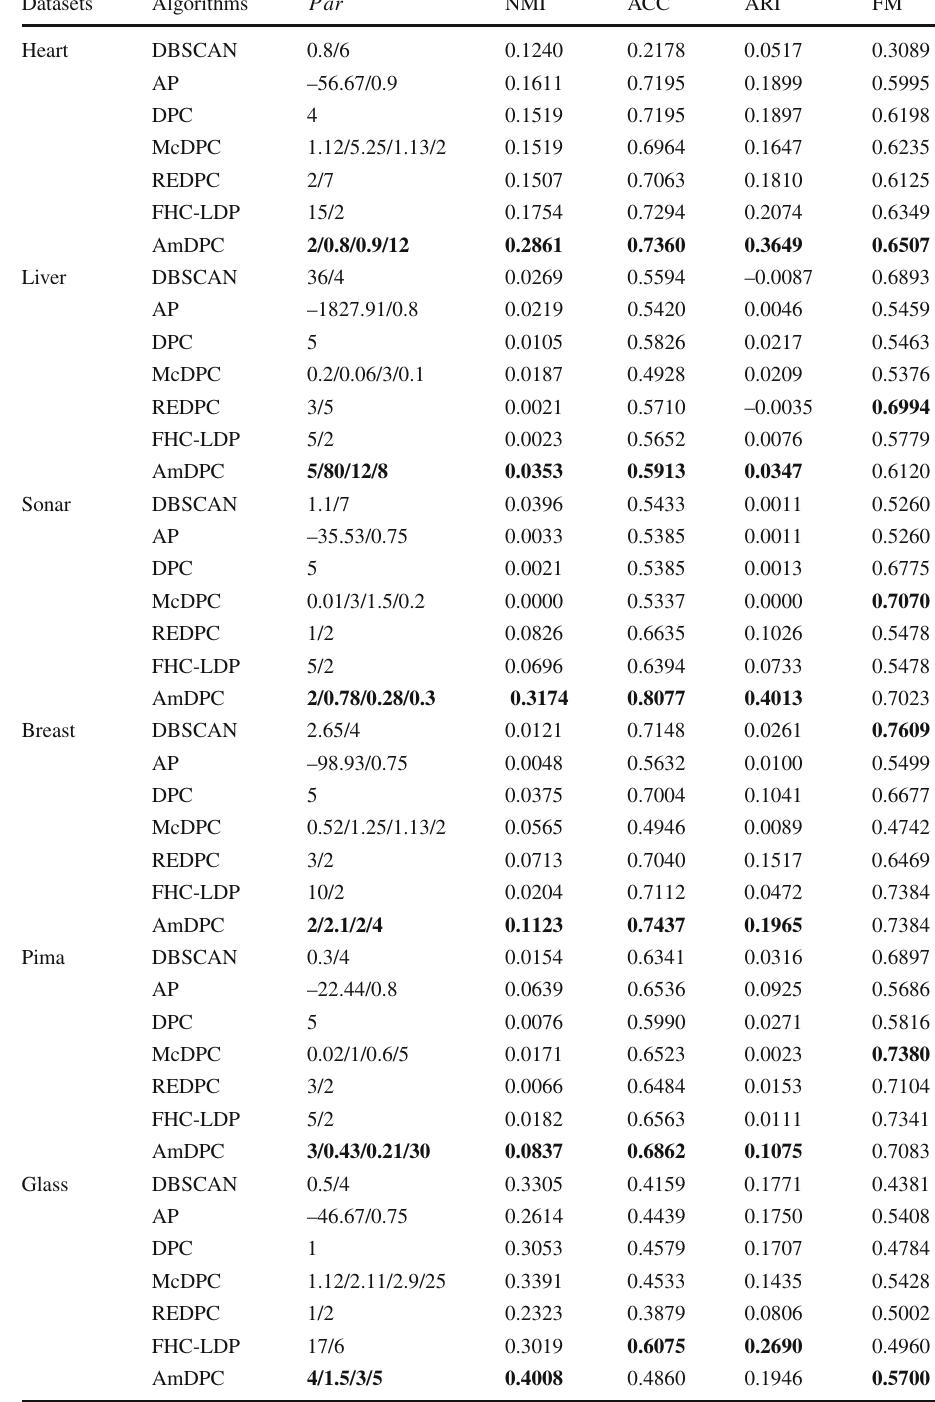
Table 3 The performance of real-world